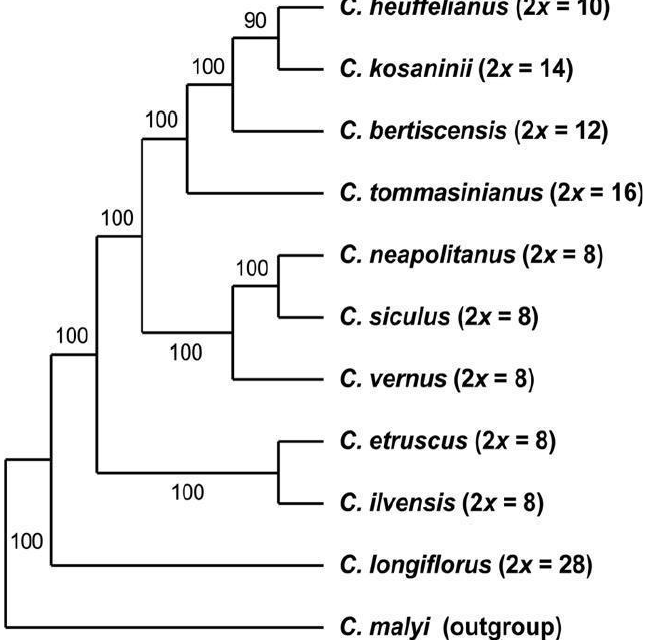
Figure 1. Phylogenetic tree of diploid species and accessions of Crocus ser. Verni based on the GBS dataset analyzed with SVDquartets analysis using the multispecies coalescent as tree model. Numbers along branches indicate bootstrap support values; chromosome numbers are provided in brackets.